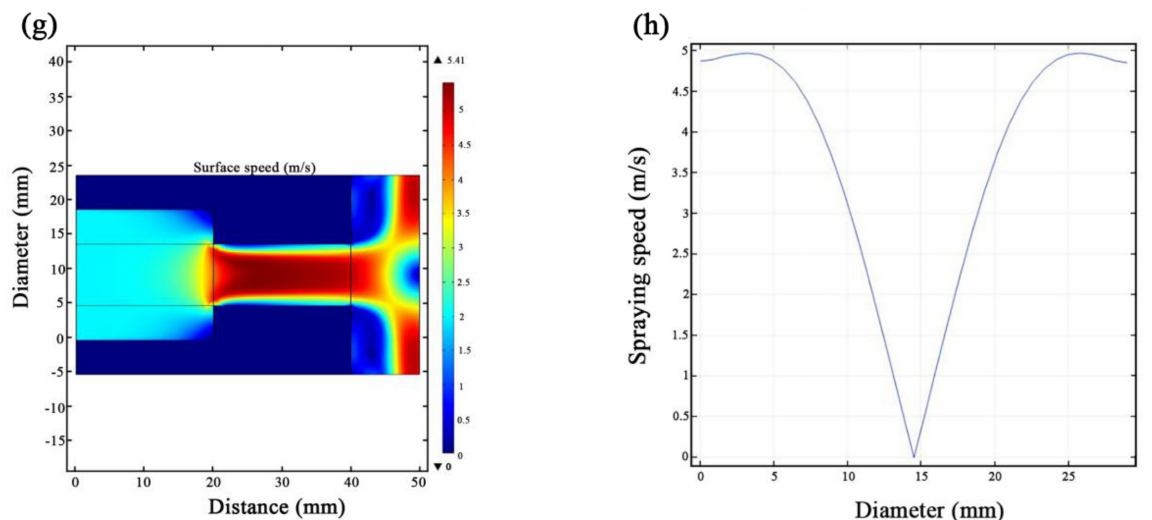
Figure 2. Simulation diagrams of the spraying speed of the electrolyte for preparing Ni–TiN coatings: